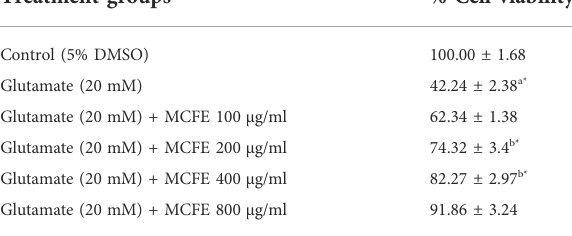
TABLE 2 Glutamate-induced neurotoxicity assay and neuroprotective effect of MCFE. Treatment